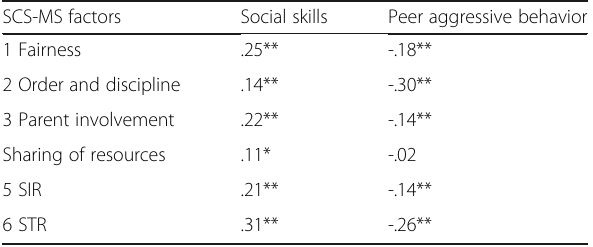
Table 2 Pearson correlations between the factors of the SCS-MS with social skills and peer aggressive behavior SCS-MS